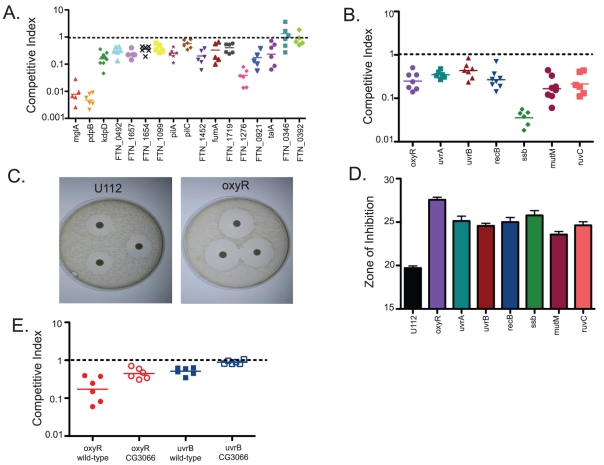
A negative selection screen of F. novicida mutants identifies bacterial genes important for bacterial growth and survival within the fly.Transposon Site Hybridization (TraSH) experiments were used to identify bacterial mutants that failed to replicate within Drosophila at a rate similar to wild-type bacteria. (A) Candidate mutants were tested individually using competition assays in which each mutant was injected into flies at a 1∶1 ratio with wild type bacteria. Following 2 days of infection, the bacteria from each fly was plated and a competitive index was determined using the ratio of mutant bacteria to wild type bacteria and comparing that to the input ratio. One sample t-tests showed that all mutants shown had competitive indexes significantly different from 1. The P values for each mutant are mglA<0.0001, pdpB<0.0001, kdpD<0.0001, FTN_0494<0.001, FTN_1657<0.0001, FTN_1654<0.0001, FTN_1099 = 0.007, pilA<0.0001, pilC = 0.0035, FTN_1452<0.0001, fumA = 0.0047, FTN_1719 = 0.0003, FTN_1276<0.0001, FTN_0921 = 0.0001, and talA = 0.0016. Two genes that were identified by TraSH but not confirmed as statistically significant, FTN_0346 and FTN_0392 are shown on the far right. Horizontal lines indicate the geometric mean. (B) Mutants of interest identified in the TraSH analysis include bacteria that are impaired in their ability to resist oxidative stress damage, including the transcriptional regulator oxyR and multiple DNA repair pathway genes. One sample t-tests showed that all mutants shown had competitive indexes significantly different from 1. The P values for each mutant are oxyR<0.0001, uvrA<0.0001, uvrB = 0.0004, recB<0.0001, ssb<0.0001, and ruvC<0.0001. Horizontal lines indicate the geometric mean. (C) Disk diffusion assay comparing oxyR to U112 wild-type bacteria demonstrated increased susceptibility to reactive oxygen produced by hydrogen peroxide (D) DNA damage repair mutants are also sensitive to oxidative stress as measured by disk diffusion assay with hydrogen peroxide. Error bars represent standard error. All of the mutants are statistically different than U112 as measured by two-tailed t-tests with P values of oxyR<0.0001, uvrA = 0.0008, uvrB = 0.0002, recB = 0.0008, mutM = 0.0008, ssb = 0.0006, and ruvC = 0.0005 (E) oxyR and uvrB mutants are rescued in CG3066 mutant flies which are unable to produce a melanization response. Both rescues are statistically significant, with P values in a 2-tailed t-test of 0.0165 and 0.0002 respectively. Horizontal lines indicate mean values.